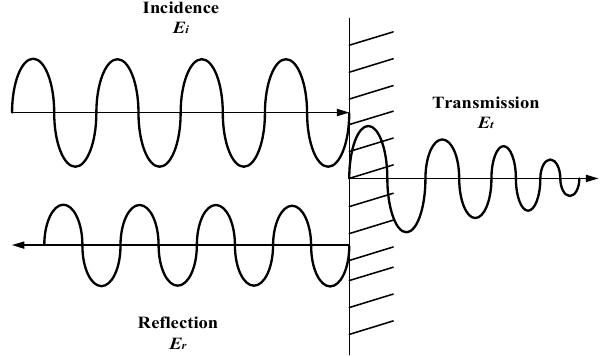
Figure 3. Reflection and refraction of perpendicularly incident light on a plane.